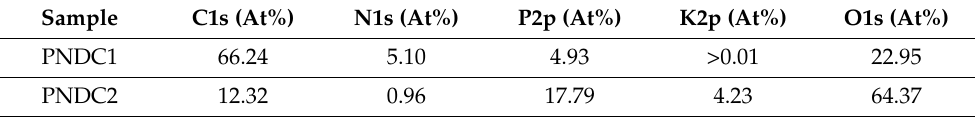
Table 3. Survey scan results of C1s, N1s, P2p, K2p and O 1s core level XPS spectra of